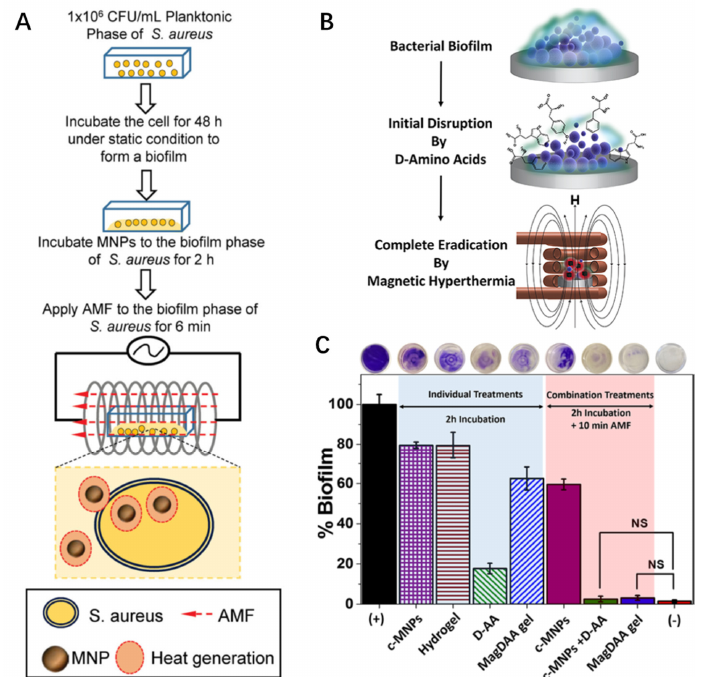
Figure 4. Different schemes of magnetothermal therapy using MNPs: ( A ) a schematic diagram of the experimental proce- dure for the application of MNP/AMF hyperthermia to the biofilm bacteria in vitro (reproduced with permission from [65]; published by CC BY, 2019); ( B ) a schematic diagram on the magnetic hyperthermia for the disruption of bacterial biofilm (reproduced with permission from [66]; published by the American Chemical Society, 2018); ( C ) biofilm disruption activity comparison of the different treatments used in this study and the corresponding crystal violet stained samples of the remaining biofilms after the different treatments (reproduced with permission from [66]; published by American Chemical Society,